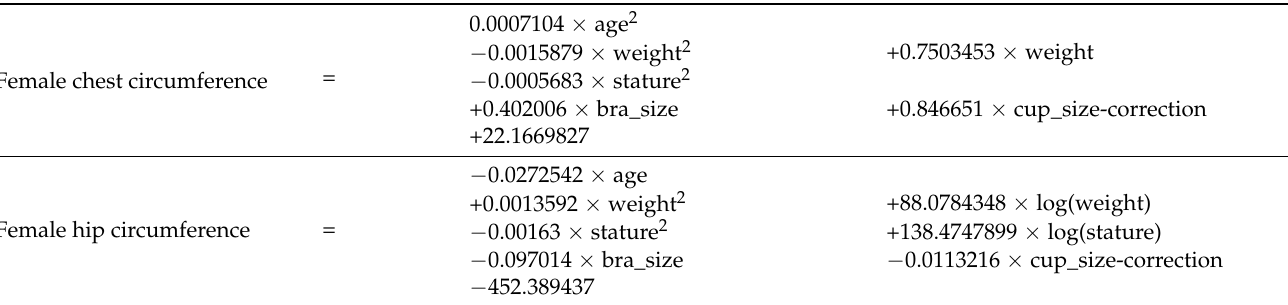
Table 7. Non-linear regression formulae to predict chest and hip circumferences for female subjects, whereby female prediction also uses bra size